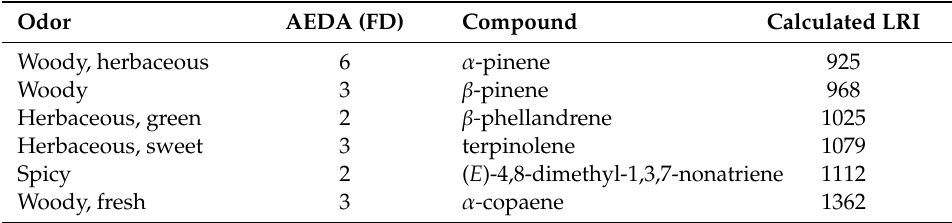
Figure 2. Aromagram of the essential oil of Coreopsis triloba S.F. Blake.